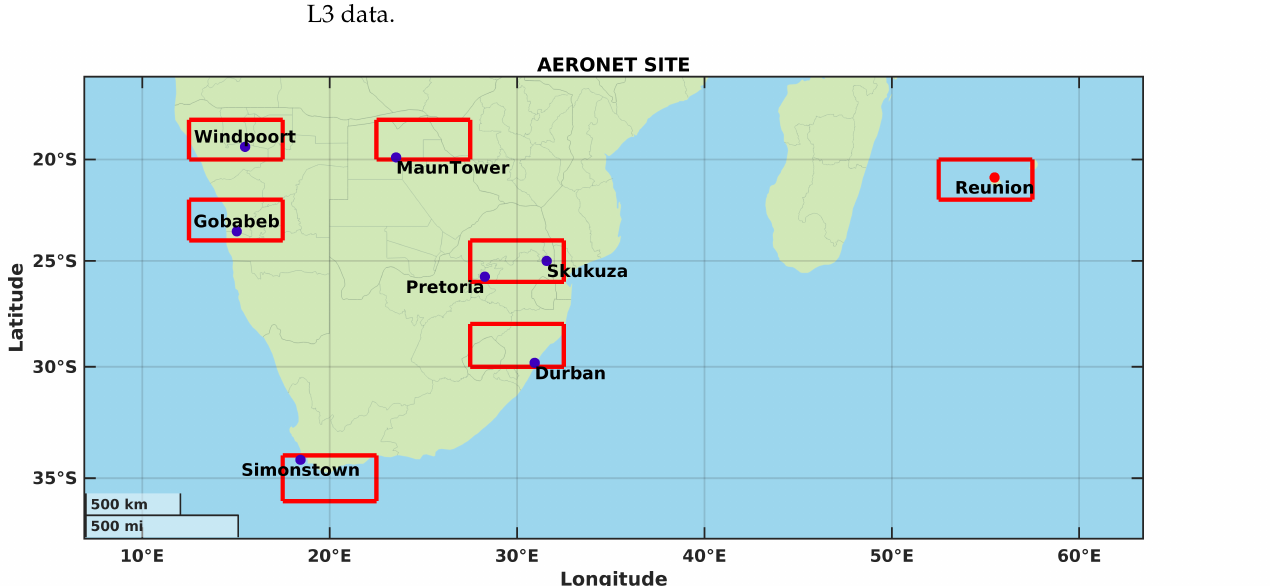
Figure A1. CALIOP grid retrieval 2.0° × 5.0°, encompassing the eight sun photometer